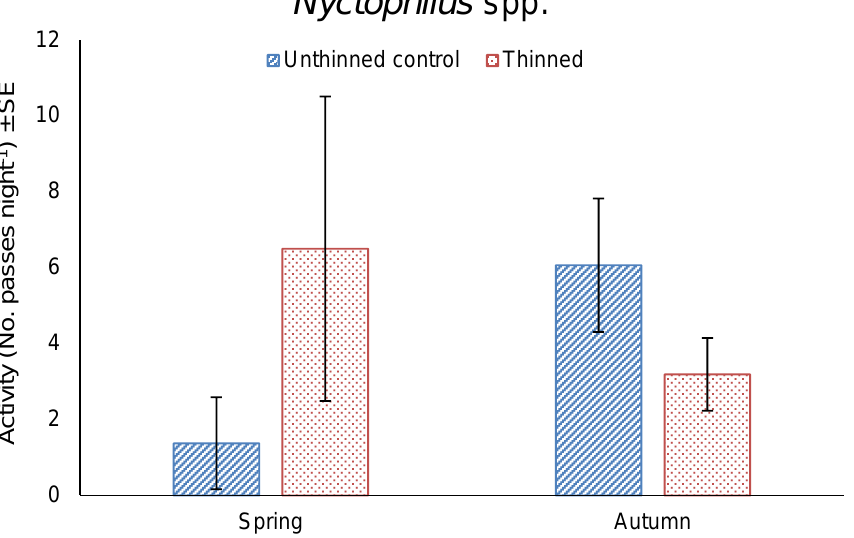
Figure 6. Mean total nightly activity ± SE of Nyctophilus spp. in unthinned and thinned treatments in spring 2016 and autumn 2017.